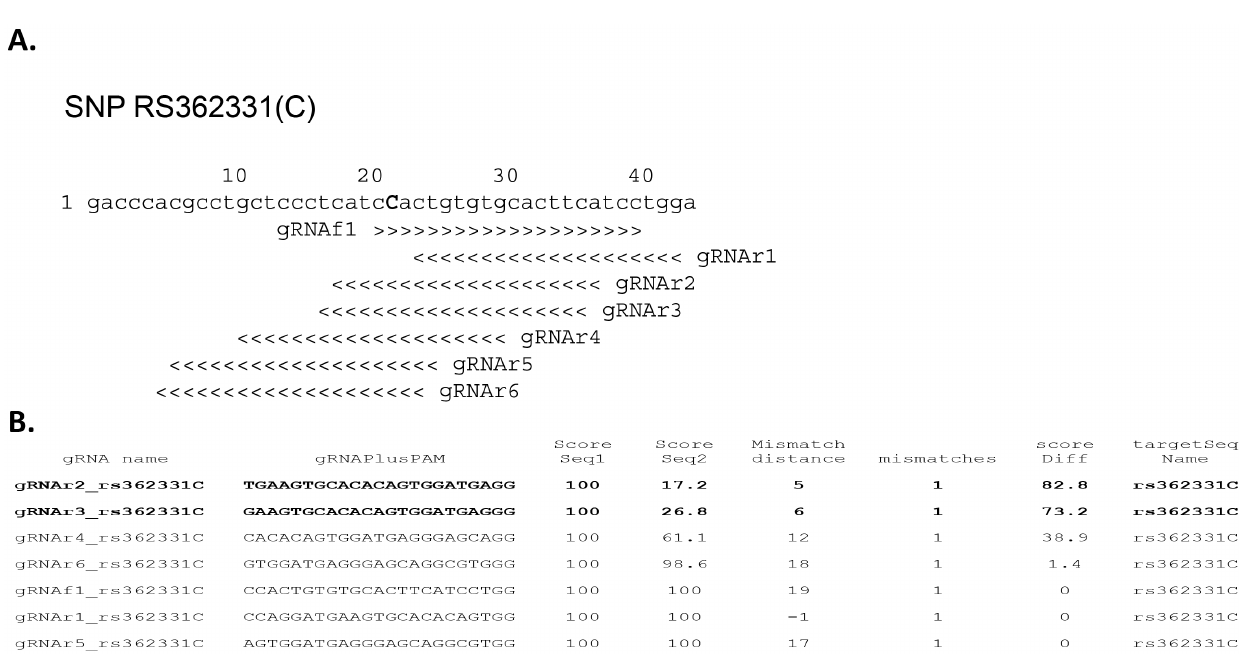
Figure 3. An example of using compare2sequences to identify gRNAs that target for the C allele of a SNP in the human huntingtin gene. A. Sequences for both alleles of the SNP RS362331 were used as inputs for compare2sequences . The input sequence used for the C allele is shown while the T allele is identical except at the position in bold. Positions of potential gRNA sequences for the C allele are visualized by inporting the genbank format output from compare2sequences into the ‘‘A plasmid Editor’’ or ApE sequence analysis program and displaying a graphical map. B. A partial output of gRNAs and their cleavage scores in each input sequence is shown. gRNAs are numbered based on their orientation (f, forward. r, reverse complement), position and input sequence name. Target site sequences include the gRNA sequence and the adjacent PAM sequence. Cleavage scores are calculated for the gRNA in both input sequences and the name and position of each mismatch relative to the PAM sequence is shown. The cleavage score difference indicates the likehood that a gRNA with a target site in one input sequence will also cleave the other input sequence. A score difference of ‘‘0’’ indicates that the gRNAs are predicted to cleave both sequences with equal efficiency; ‘‘100’’ indicates that the gRNAs are predicted to be specific for just one sequence. The gRNAs in bold are candidates to show greater activity for the C allele compared with the T allele.